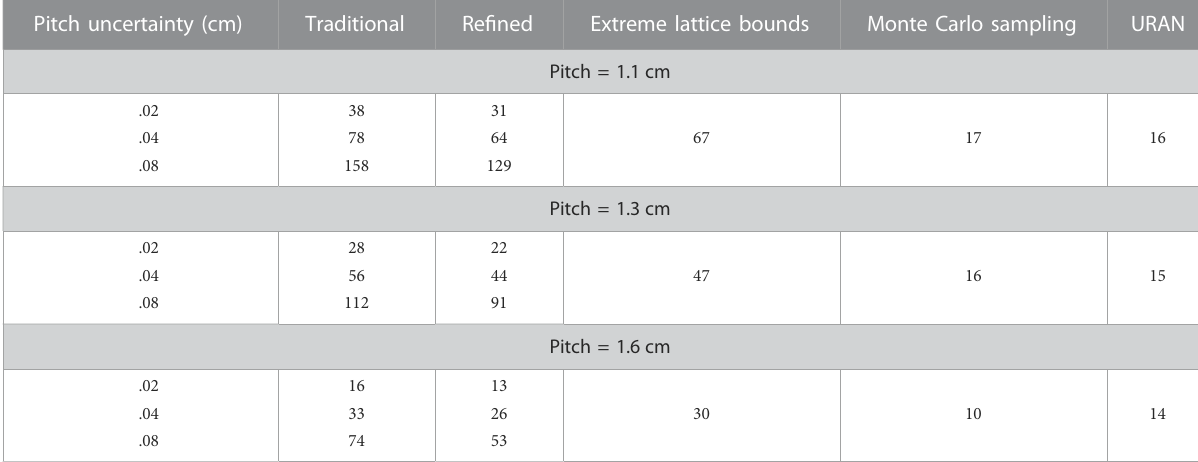
TABLE 4 Comparison of Methods for Pitch 1 σ Uncertainty (in pcm). Pitch uncertainty